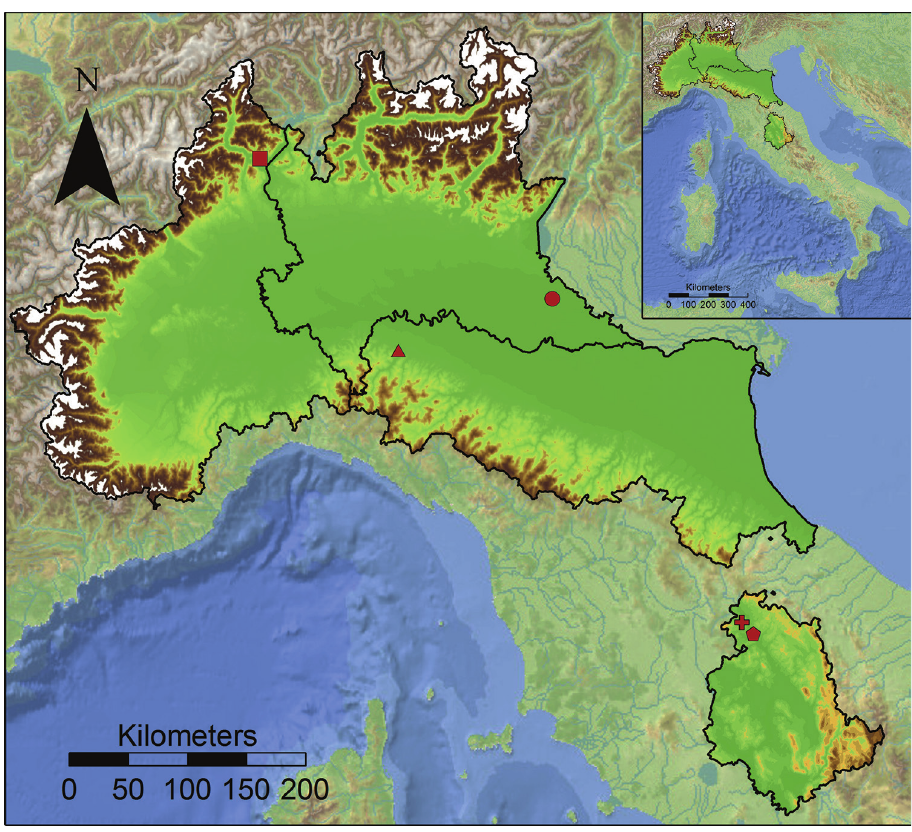
Figure 1. Overview of the study sites in five localities in Italy. Square: Monterosso (MON), Piemonte Region; Circle: Bosco Fontana (BOF), Lombardia Region; Triangle: Croara (CRO), Emilia-Romagna Region; Cross: Tocerano (TOC), Umbria Region; Pentagon: Felceto (FEL), Umbria Region. and hornbeam ( Carpinus betulus ), with some introduced species such as the